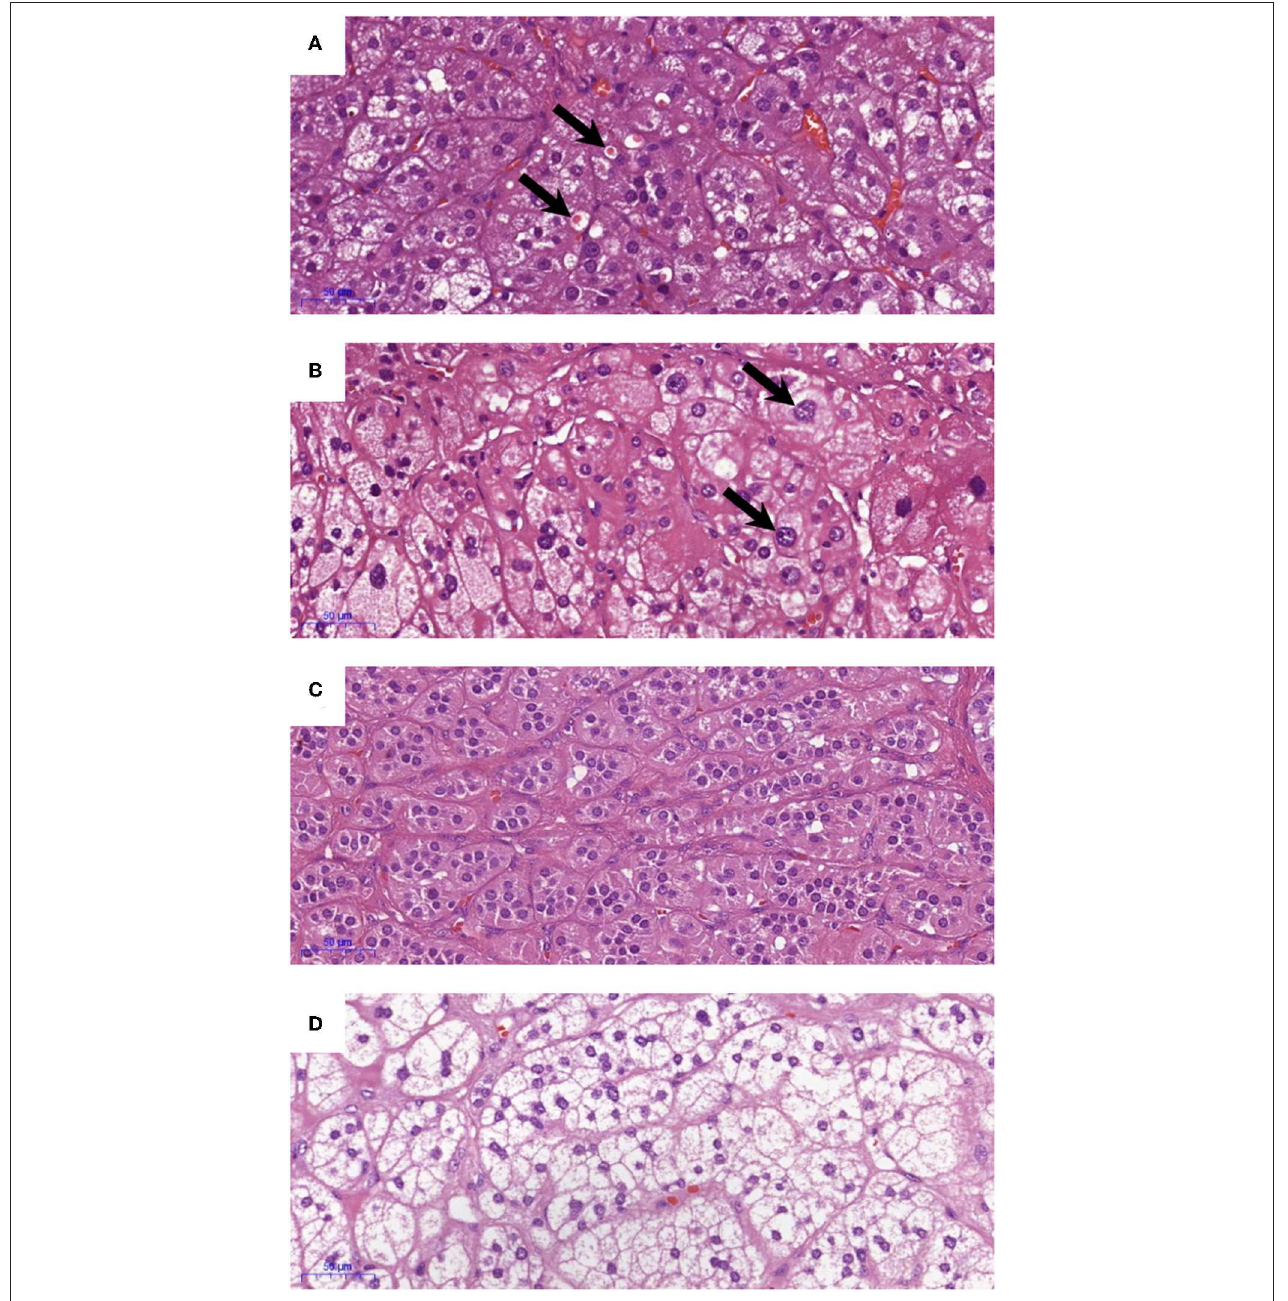
FIGURE 2 | Examples of histopathology morphology based on hematoxylin and eosin (H&E) staining. (A) Spironolactone bodies, (B) atypical cells, (C) ZG-like cells, and (D) ZF-like